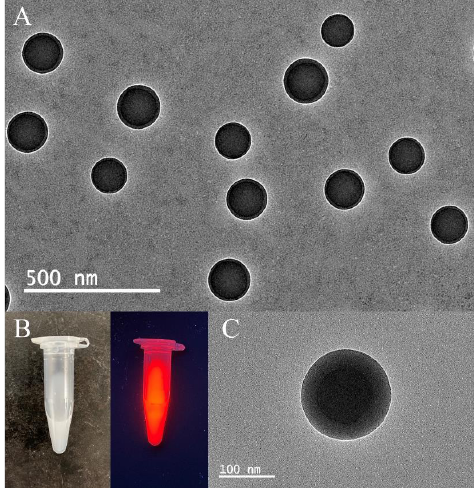
Figure 4. ( A ) TEM image of fluorescent PS microspheres. ( B ) Photograph of fluorescent PS microspheres under natural light and 365 nm ultraviolet light. ( C ) TEM image of fluorescent PS microspheres with 5 times the amount of p-toluenesulfonyl chloride.